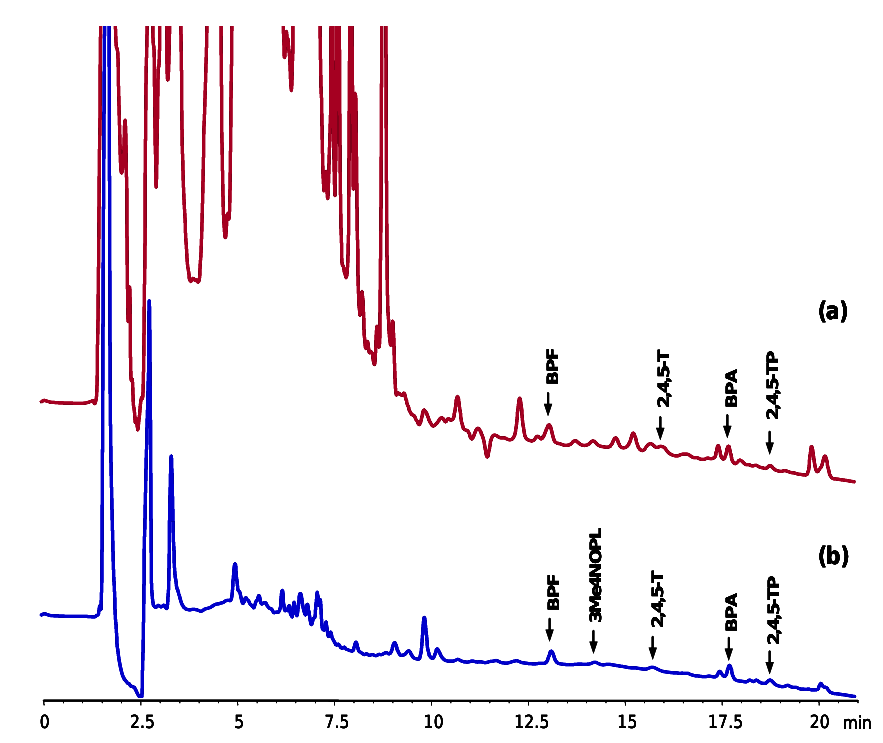
Figure 6. Chromatograms obtained for the MISPE extraction of 20 mL urine spiked with 25  g L −1 of each analyte, without ( a ) and with ( b ) the addition of 5% of acetonitrile to the sample. Washing step: 5 mL of dichloromethane. Elution step: 5 mL of acetonitrile:acetic acid (9:1,